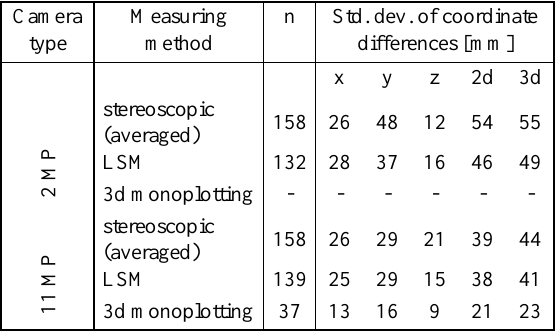
Table 3. Relative accuracy